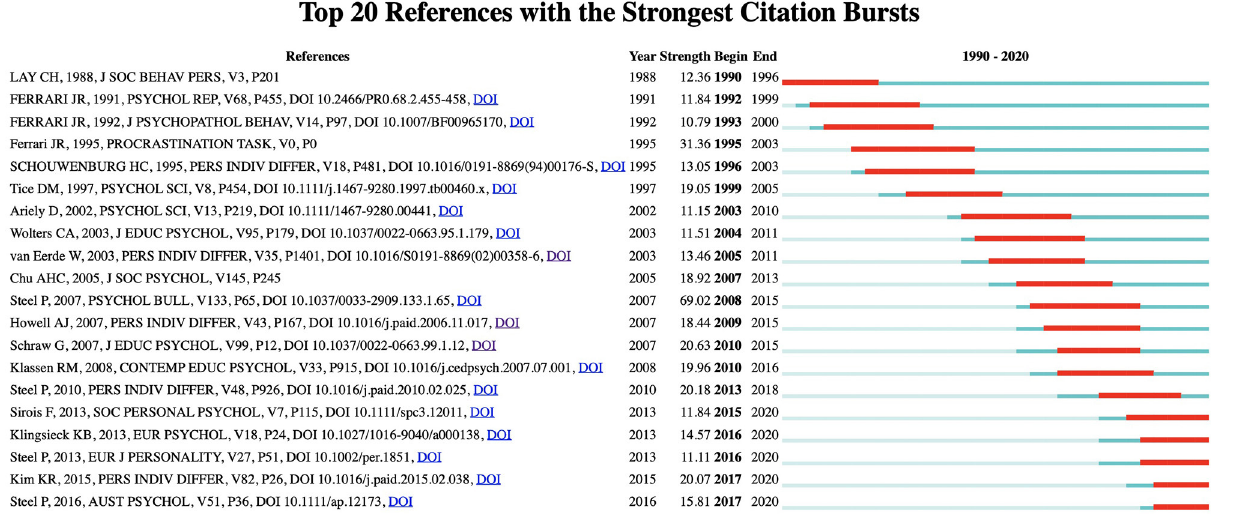
FIGURE 5 | Top 20 references with the strongest citation